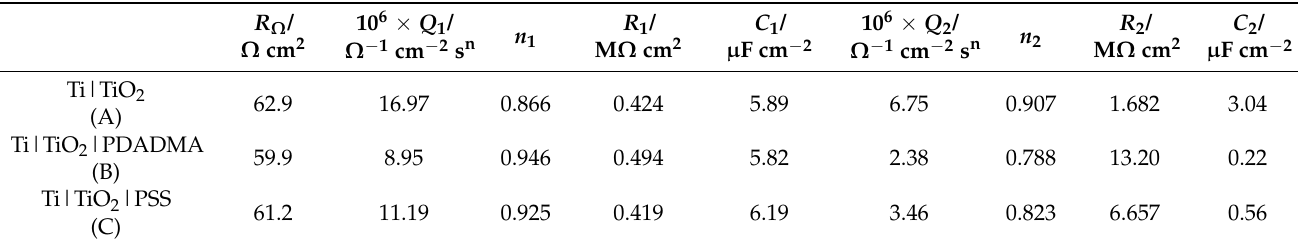
The impedance parameter values obtained by described EEC model fitting are pro- vided in Table 3. Impedance parameters values of the unmodified (Ti|TiO 2 ) and polyelectrolyte modified Ti electrodes Table 3. Impedance parameters values of the unmodified (Ti|TiO 2 ) and polyelectrolyte modified Ti electrodes (Ti|TiO 2 |PDADMA and Ti|TiO 2 |PSS) recorded at E OC in 0.1 mol dm − 3 NaCl solution. (Ti|TiO 2 |PDADMA and Ti|TiO 2 |PSS) recorded at E OC in 0.1 mol dm − 3 NaCl solution. R Ω / Ω cm